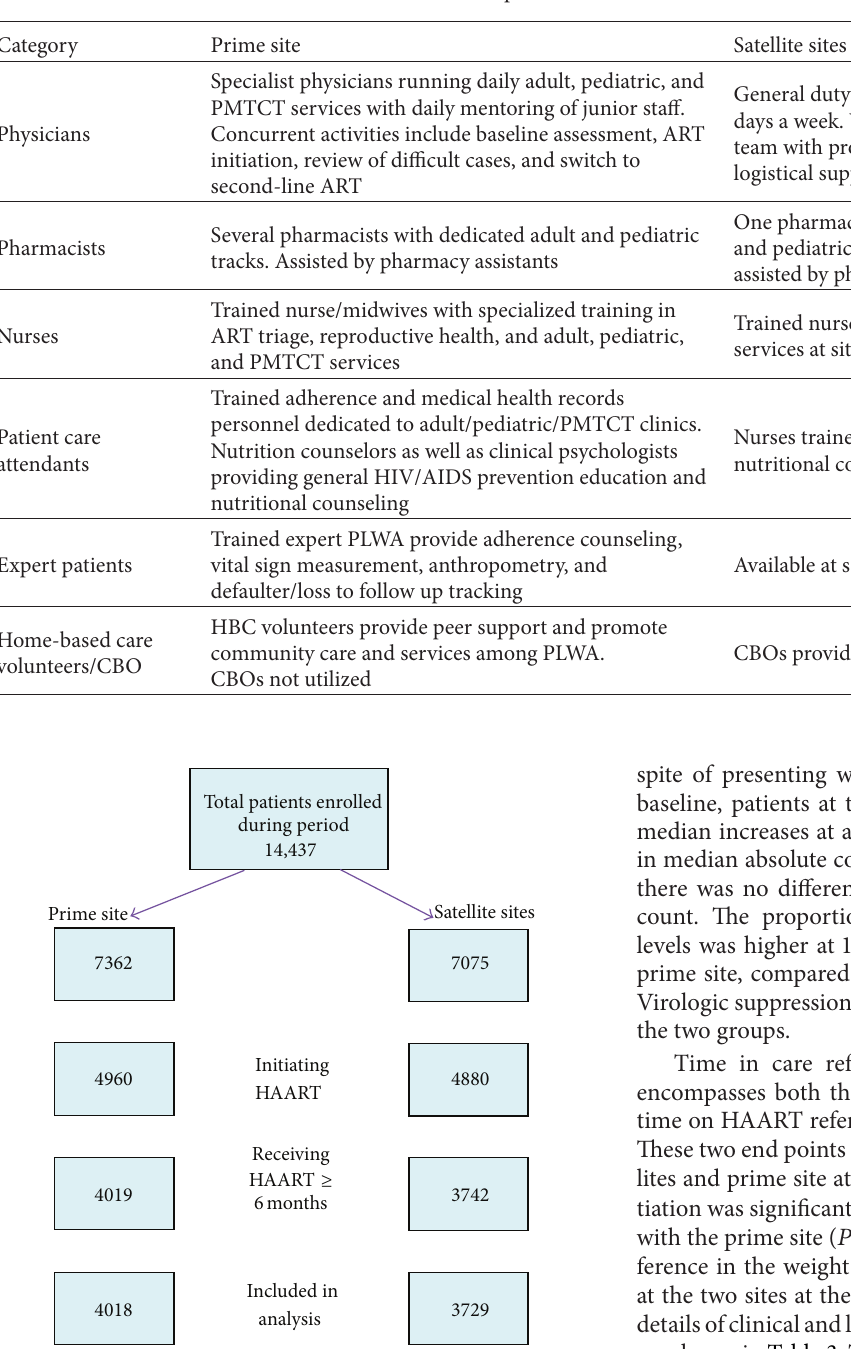
between patients at the satellite and prime sites are shown in Table